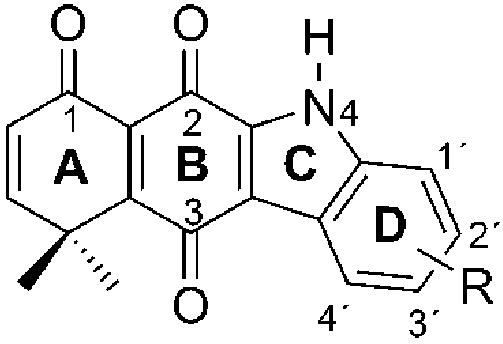
Figure 1. Structure of o -carbonyl carbazolequinones.